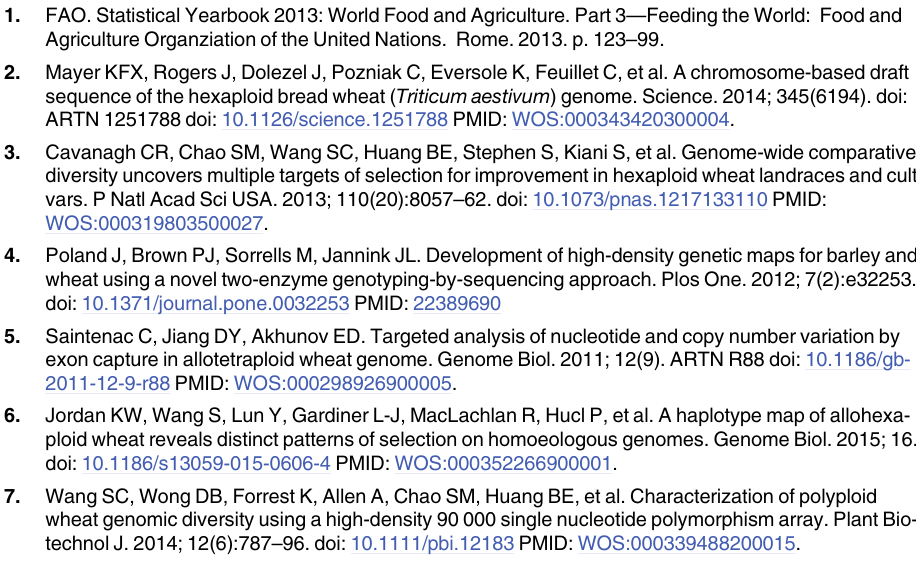
S1 Table. Map and markers data of Norstar by Cappelle Desprez. S2 Table. Map and markers data of Norstar by Manitou. S3 Table. Map and markers data of Norstar by winter